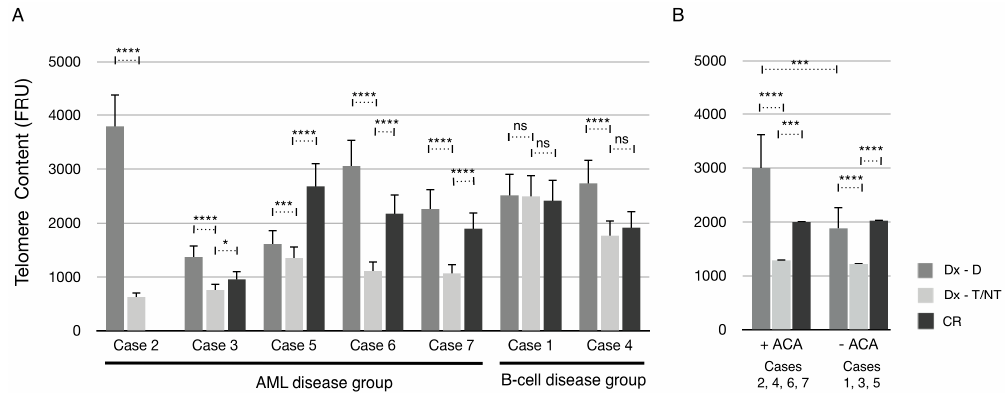
Figure 6. Mean telomere content of patients in the AML and B-cell disease groups. ( A ) Telomere content in the nuclei of each patient at diagnosis and after ploidy scoring into diploid (Dx-D) or as T/NT (Dx-T/NT) nuclei, and at CR. ( B ) Average telomere content when nuclei were grouped according to presence of additional chromosomal aberrations (+ACA) or their absence ( − ACA) after ploidy scoring into diploid (Dx-D) or T/NT (Dx-T/NT) nuclei, and at CR. After significance testing number of asterisk indicates level of significance as described in Figure 2.